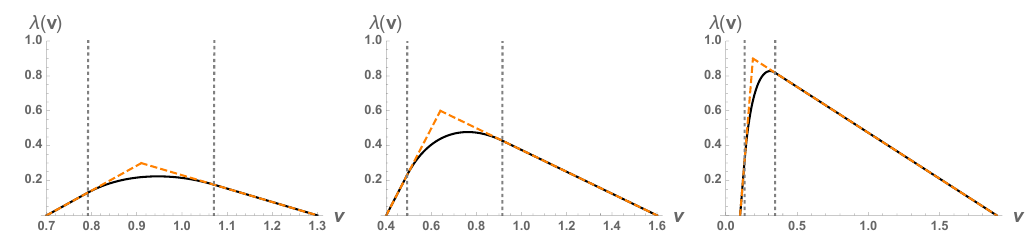
Figure 9 . Velocity dependent Lyapunov exponent (black solid) against the bound (2.8) (orange dashed) along with the critical velocities (gray dotted) in the chiral SYK model (for (cid:12) = 2 (cid:25) ). The couplings from left to right are J = 0 : 3 ; 0 : 6 ; 0 : 9. asymmetric butter(cid:13)y cone, with upper and lower butter(cid:13)y velocities v +